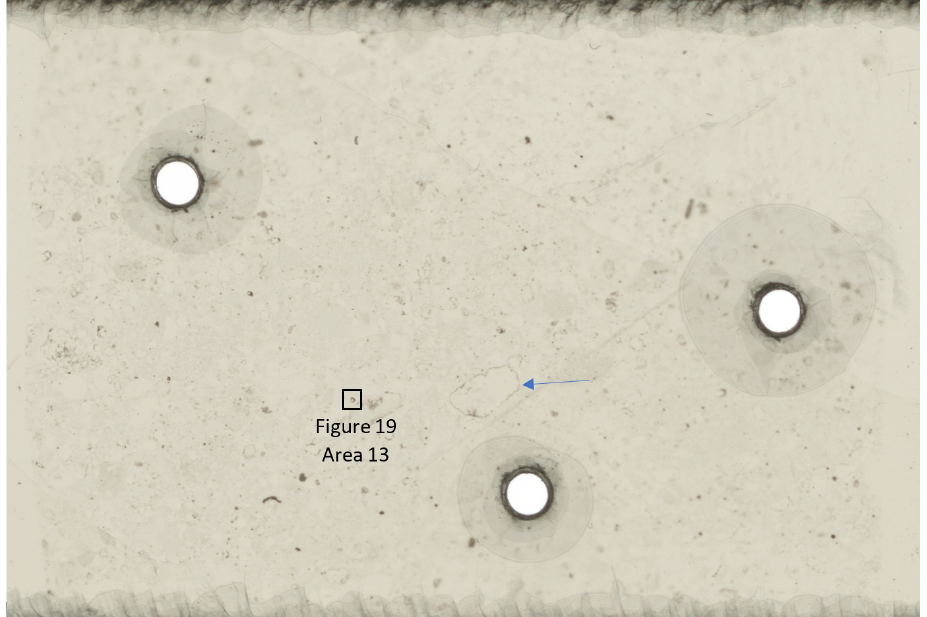
Figure 10. Fission-track mica image for GJAST − 20 − 10 (total digestion uranium concentration of 13.2 mg/kg). Arrow indicates large grain with a fission-track rind. Rectangle indicates zoomed-in area with associated figure number. White circles are drill holes used to align the fission-tracked mica and the thin section. Length is 32 mm.